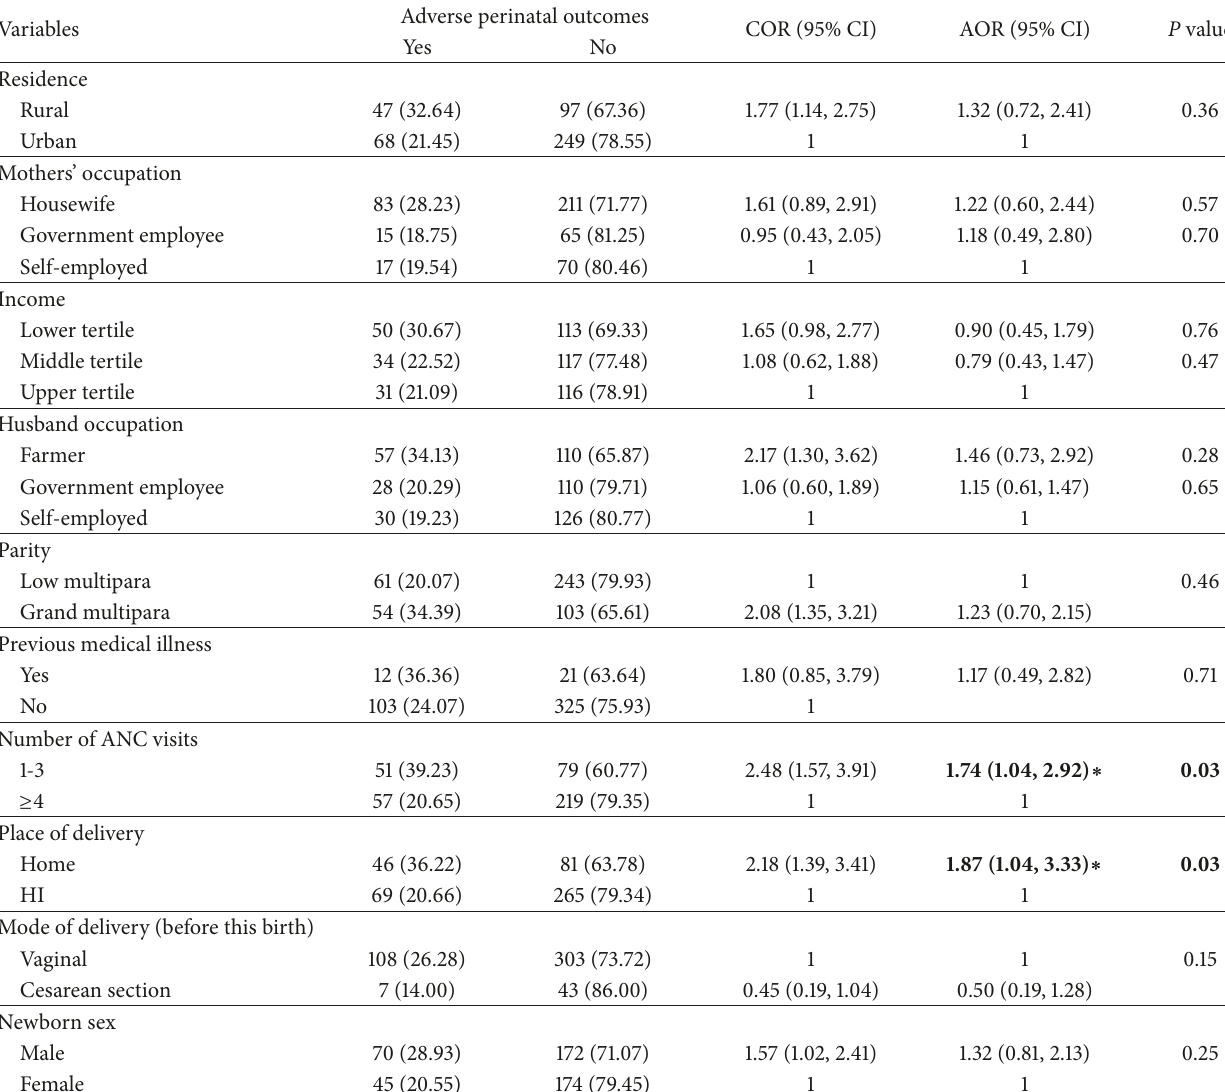
Table 3: Univariable and multivariable logistic regression analysis of variables with adverse perinatal outcome in HUCSH & AGH, Southern Ethiopia